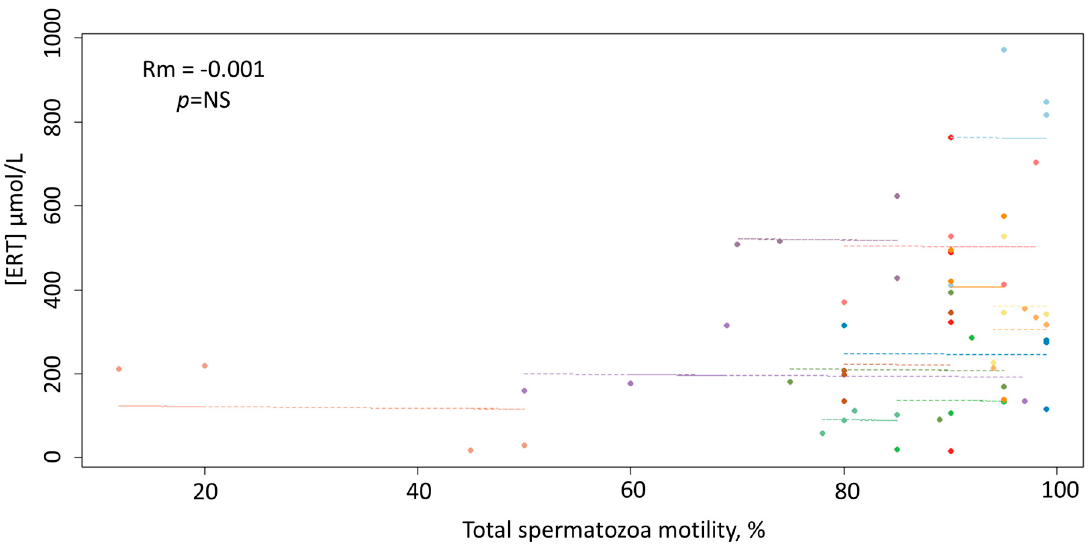
Figure 3. Scatterplots of the linear relationship between the concentrations of ERT and the total spermatozoa motility.